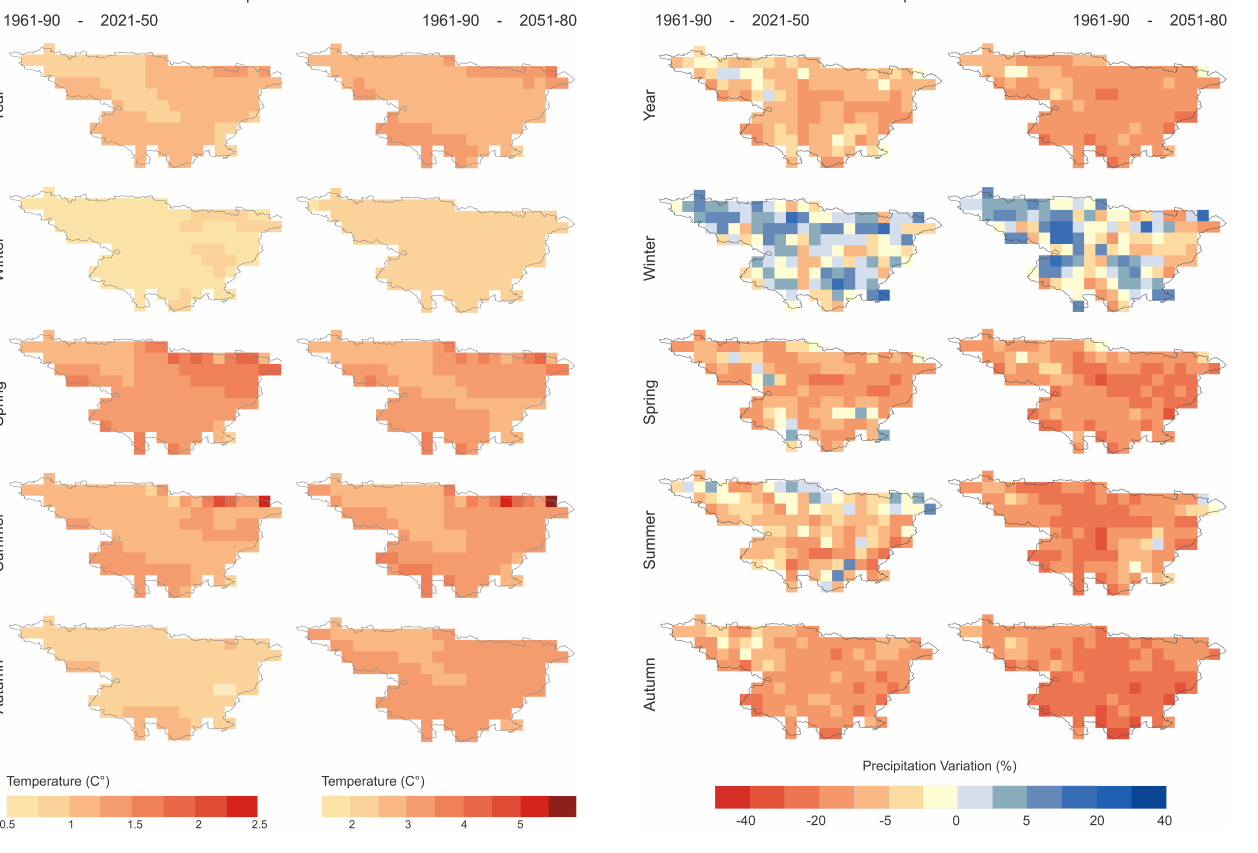
Fig. 8. Projected changes in temperature under the HIRHAM5 model (A1B emission scenario) for the time slices 2021–2050 and 2051–2080 compared with the 1960–1990 period.